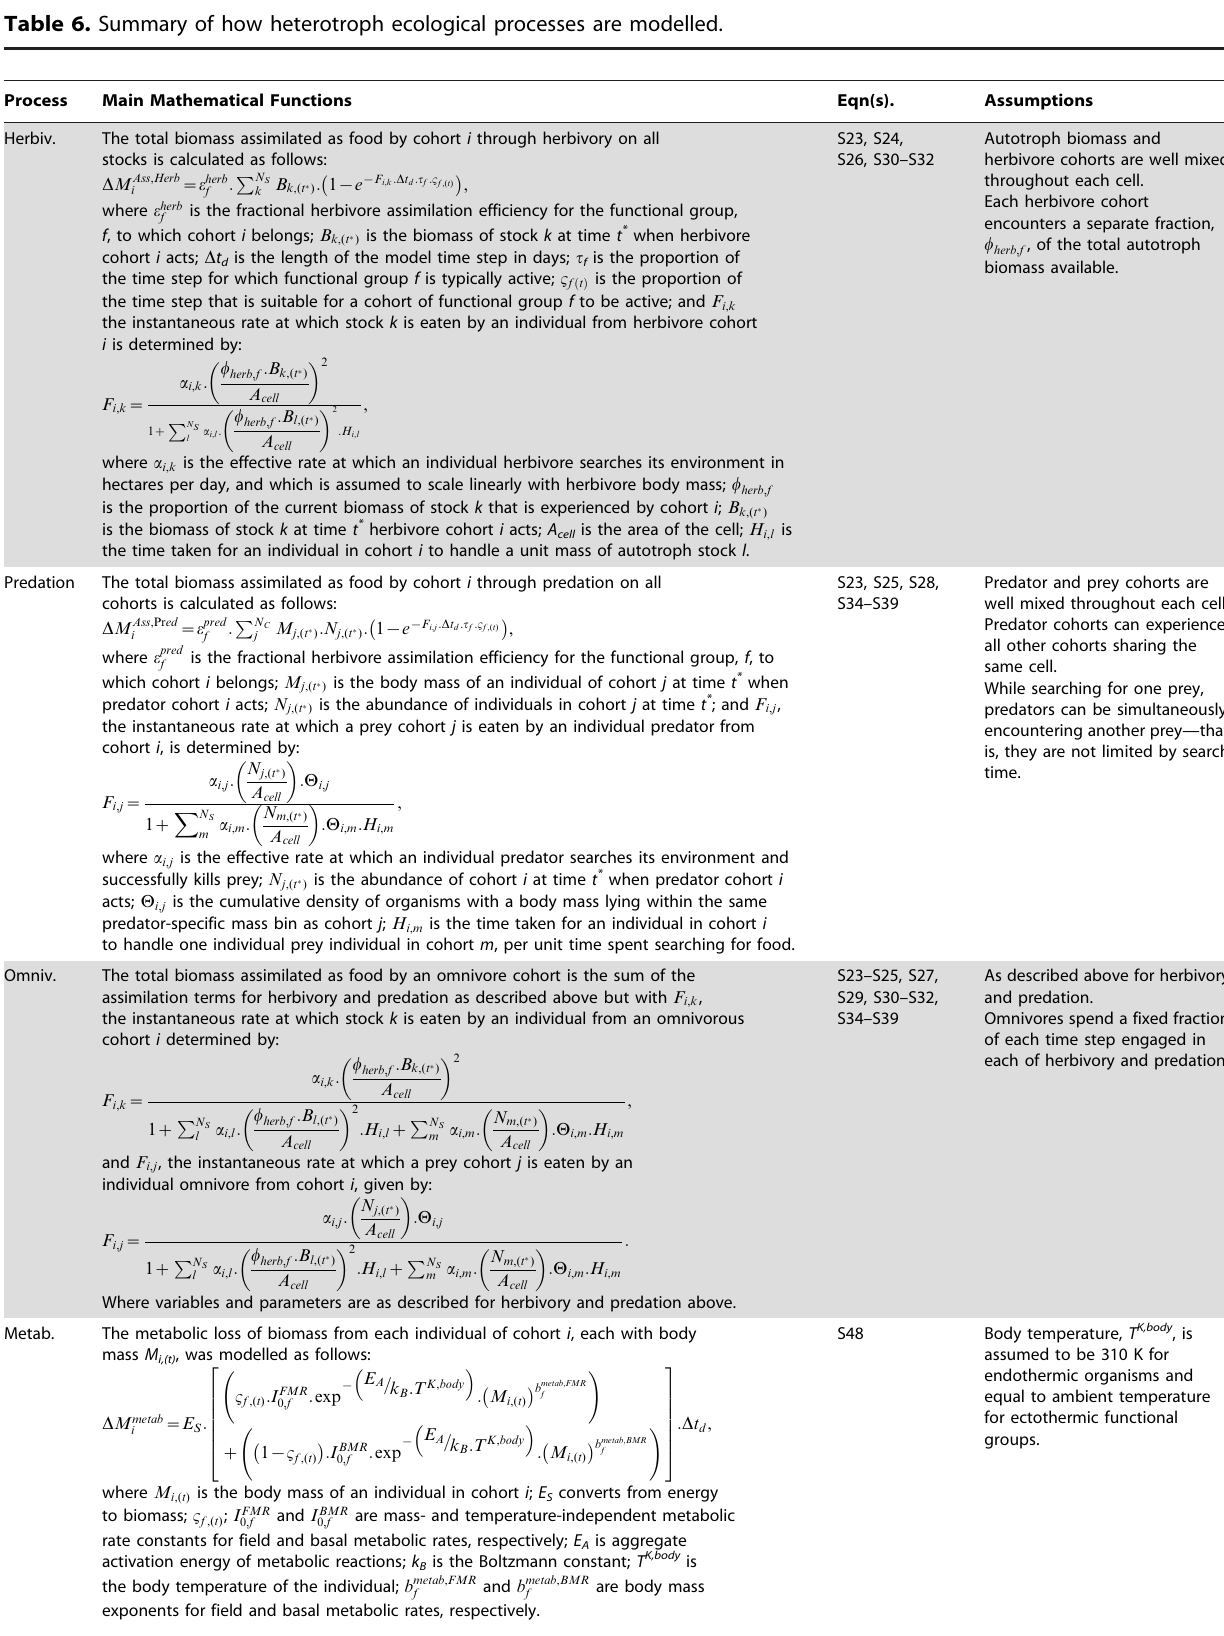
Process Main Mathematical Functions Eqn(s).